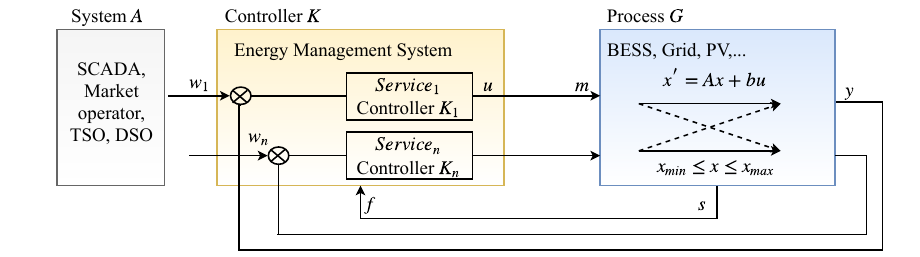
Figure 3. Usage of EMS in the context of multi-functional BESS. Table 3. Use cases built-in an